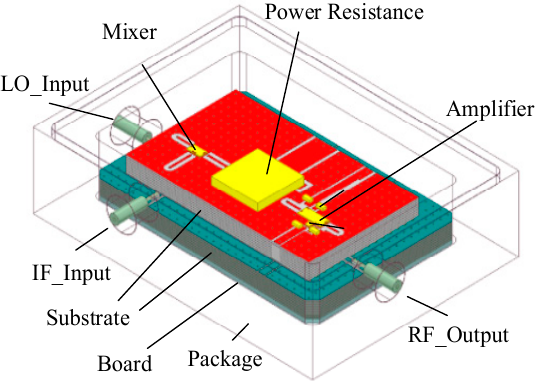
Figure 4. Schematic view of the real-life System-in-Package.